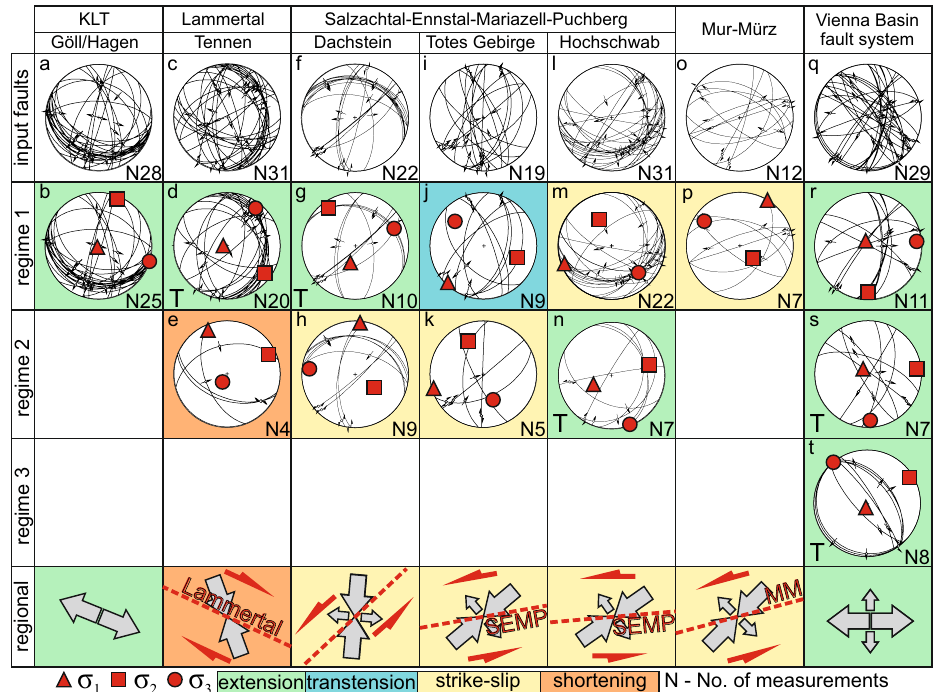
Figure 3. Fault-slip data divided into fault-sets reactivated in different regimes; great circles: blue-normal faults; red—reverse faults; part of faults not matching any of the regimes have been rejected; regional stress is the mean of the computed horizontal compressions or extension and excludes local topographic influences denoted by